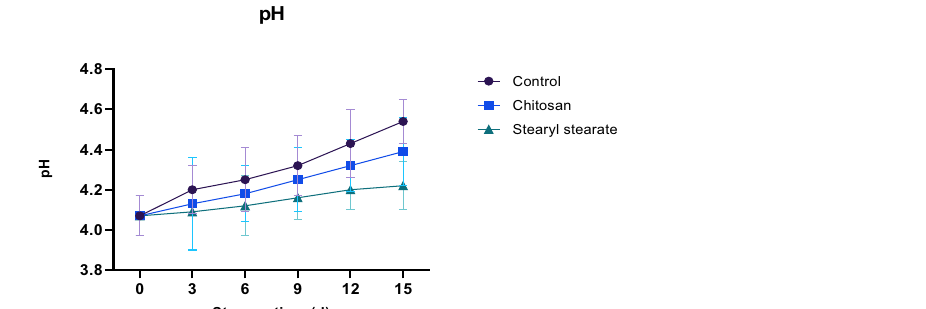
Figure 3. Changes in pH of stored tomatoes.